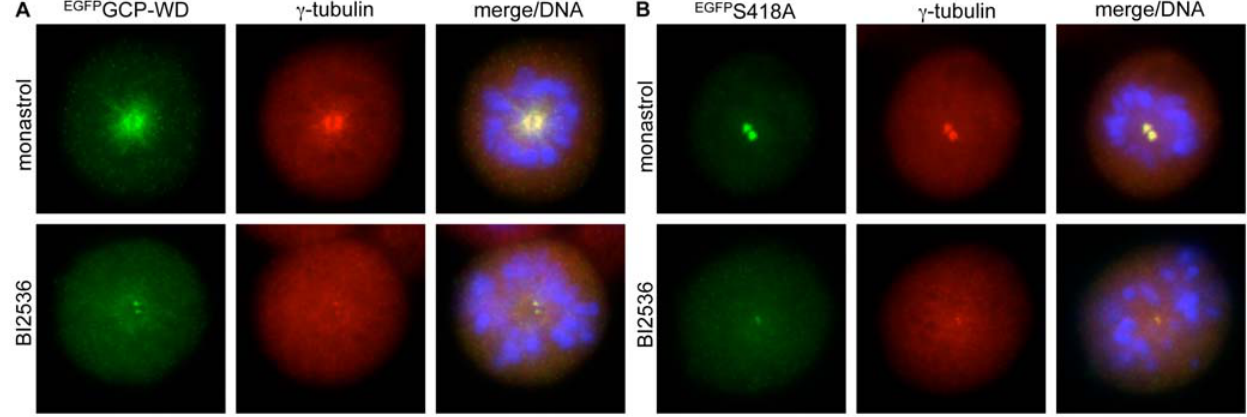
Figure 3. The S418A mutation does not affect centrosome localization of GCP-WD. HeLa cells depleted of endogenous GCP-WD and transiently expressing RNAi-resistant EGFP-tagged GCP-WD wt (A) or S418A mutant (B) were treated with monastrol or BI2536, fixed and immunostained with antibodies against GFP and c -tubulin. DNA was visualised using DAPI.